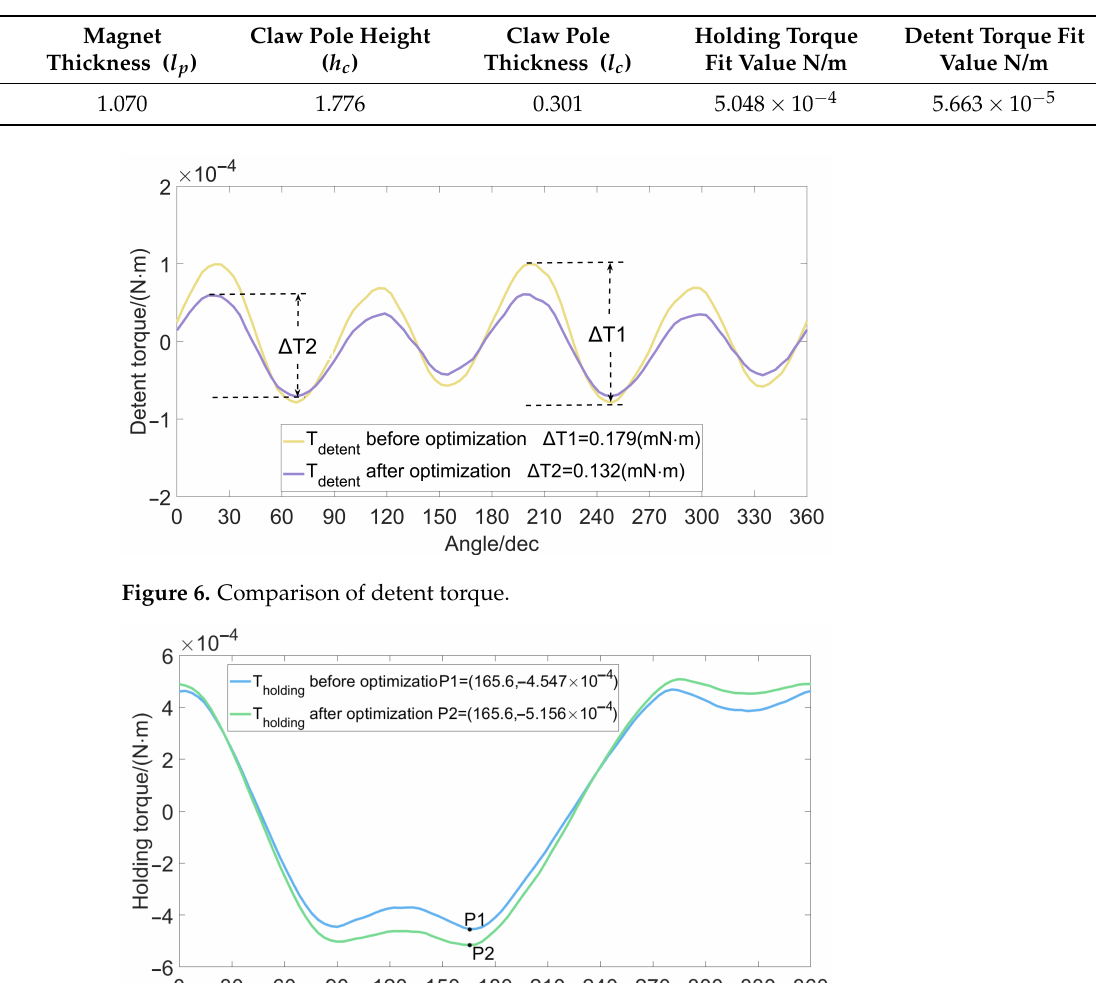
Table 6. Optimization analysis parameters.